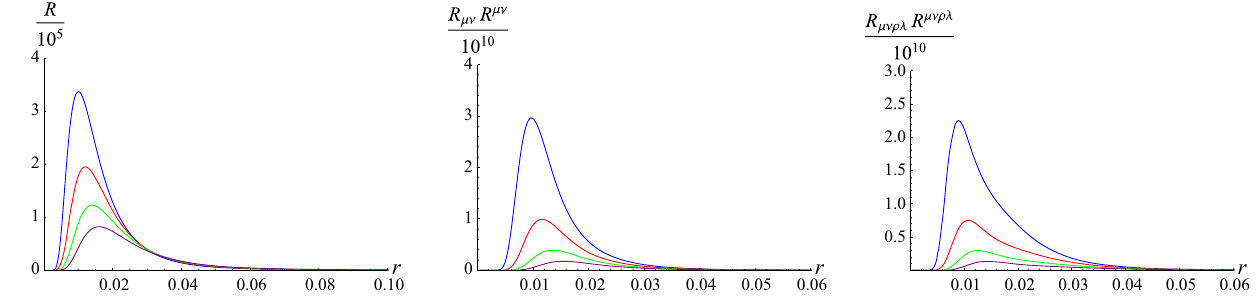
Fig. 1 We plot the curvature scalars R (left), R μν R μν (middle), and R μνρλ R μνρλ (right) in terms of r , for the different values of the characteristic parameter k of the non-linear electrodynamics, at l = M = 1 and m = 0. The blue, red, green and purple curves correspond to k = 0 . 1, 0 . 12, 0 . 14, 0 . 16,